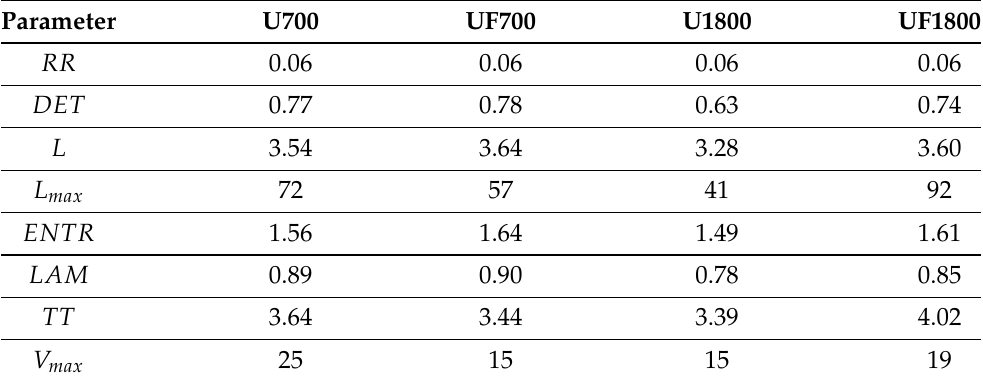
Figure 17. RPs from the two methods for Case 1 and Case 2, at 1800 rpm: without friction ( a , c ); with friction ( b , d ). Table 3. Quantification of SDEMDI